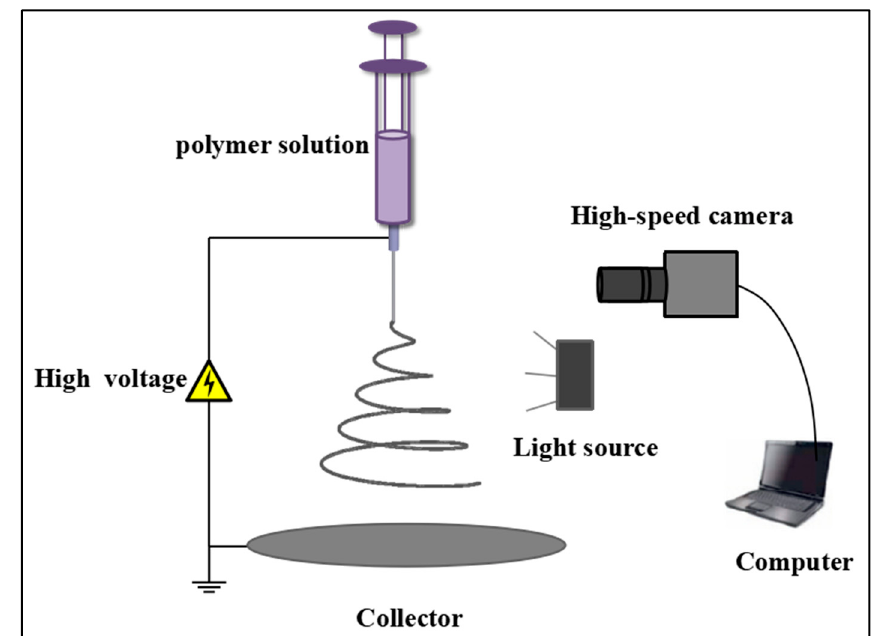
Figure 1. Schematic of experimental setup.